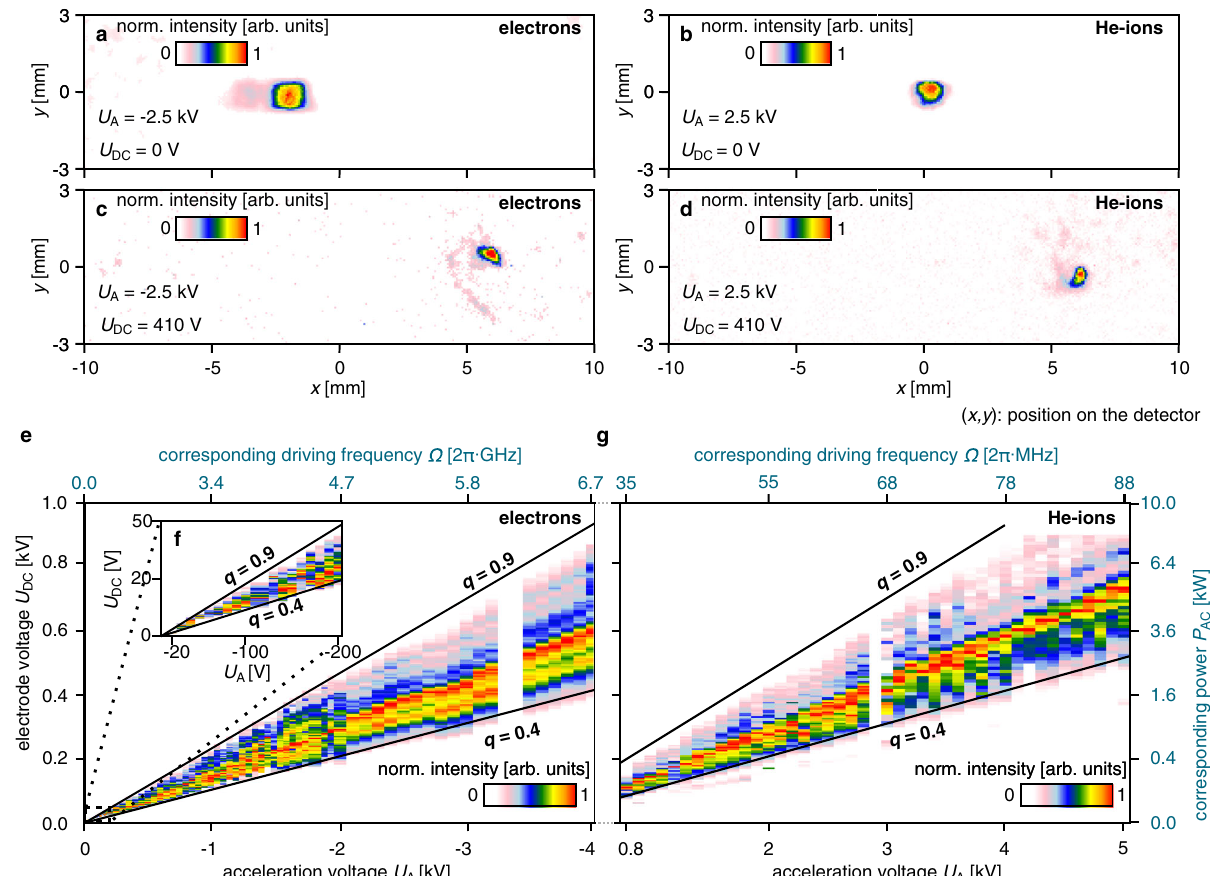
Fig. 3 Auto-ponderomotive guiding of various species of charged particles. a , b Detector images of unguided electron a and helium ion b beams with electrodes grounded ( U DC = 0 V). c , d With charged electrodes ( U DC = 410 V), both beams are guided and are measured at x = 5.9 mm (electrons) and x = 6.1 mm (He-ions), almost exactly at the expected position of x = 5.8 mm. The barely visible curl structure results from spiraling trajectories of off- centrally injected particles. The detector signal of helium ions is expected to be the vertically mirrored image of the electron signal, due to the opposite sign of their charge, which can just be discerned. e , g Guiding stability: normalized intensity of guided electrons e and helium ions g on the MCP detector. For each acceleration voltage U A , the applied electrode voltage U DC was scanned from 0 to 1 kV and the guiding signal of each scan was normalized to its maximum value. For comparison with electrodynamic traps, the corresponding driving frequency and AC power (impedance of 50 Ω ) are given on the secondary axes (blue). Black lines corresponding to operation at q = 0.4 and q = 0.9 are drawn in e and g as a guide to the eye. Even though their masses differ by more than fi ve orders of magnitude, guiding starts for all particles at q ≈ 0.4 and no guiding is observed for q values >0.9, perfectly matching our particle tracking results. Because not all kinetic energies were possible to realize due to the source, some regions are left white. f Magni fi ed image of a part of e showing that electrons are guided for kinetic energies as low as 20 eV, which was the lowest energy we could achieve with our